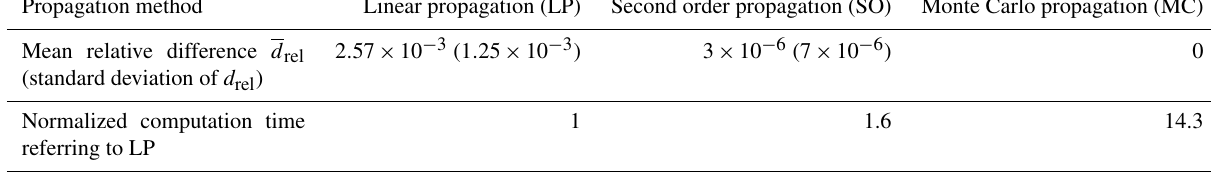
Table 1. Comparison of propagation methods concerning relative difference and normalized computation time in arbitrary units.